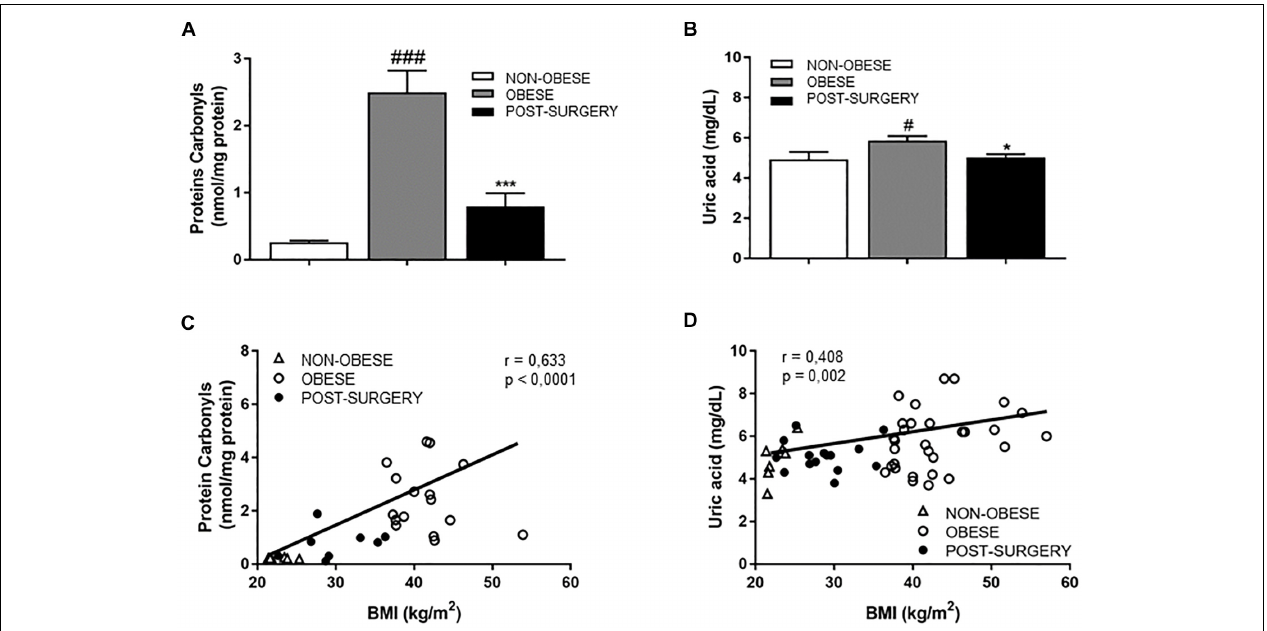
FIGURE 2 | (A,B) Diagram bars shows protein carbonyls (A) and uric acid (UA) concentrations (B) in plasma samples from non-obese (white bar, n = 7), obese (gray bar, n = 31) and post-surgery (black bar, n = 17) patients. (C) Correlation between protein carbonyl concentrations in plasma and BMI. (D) Correlation between plasmatic UA levels and BMI. White triangles correspond to non-obese, white circles correspond to obese and black circles correspond to Post-surgery. Data are expressed as mean ± SEM. # p < 0.05 and ### p < 0.001 compared with the non-obese group. ∗ p < 0.05 and ∗∗∗ p < 0.001 compared with the obese